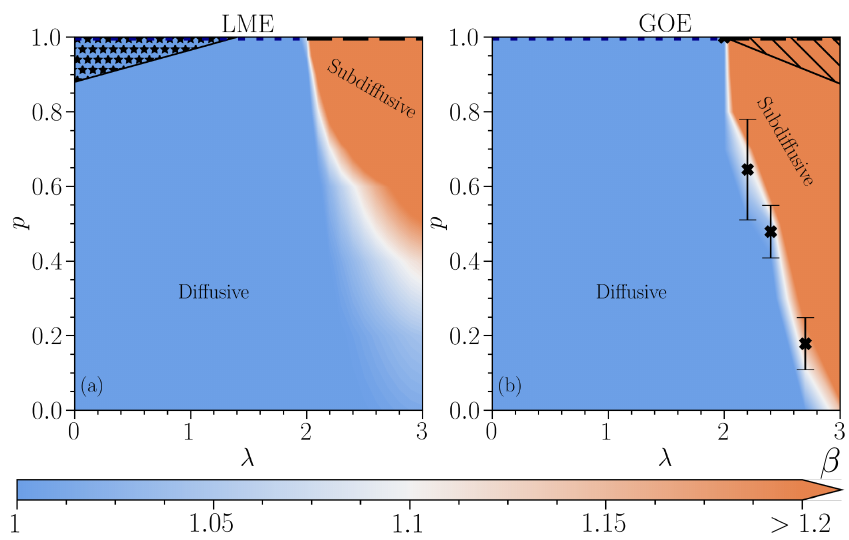
Figure 9: Transport phase diagram of the AAH model coupled to random MDB (a) or GOE (b) baths as a function of the thermal inclusion probability p and the strength of the quasi- periodic potential λ . At p = 1 we see the expected transition from a conducting phase with ballistic transport to a localized one, with exponentially small resistance. As p decreases from one the transport exhibits a transition between a diffusive and a subdiffusive phase. The white region indicates the region where transport is compatible with diffusion up to two ( p ) lies in this region. The black cross markers are error bars. The transition line λ = λ c examples of extrapolation points, with associated error estimations. Close to p = 1, in panel (a) the hatched area exhibits a region compatible with superdiffusion, which we cannot fully resolve with our numerical data. Conversely, in panel (b) the hatched area exhibits a region compatible with localization which, similarly, we cannot fully resolve with our numerical